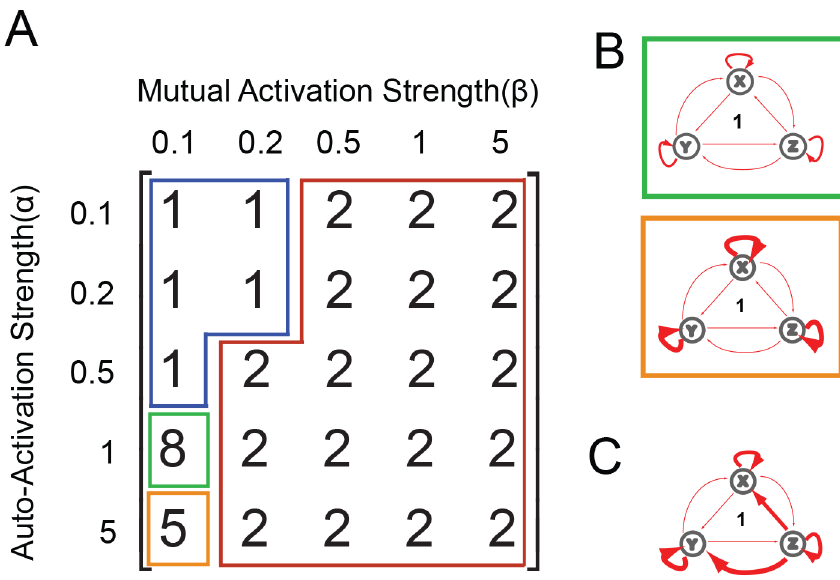
Figure 6. Stable Steady State Analysis of Network 1. (A) A matrix defined by examining the number of SSS present at points where all auto- regulatory strengths (row) are equal and mutual-regulatory strengths (column) are also equal. This provides an overview of network stability at various points in the parameter regulation space; the green and brown regions are visualized as FCT diagrams independently in B. (B) The green- boxed diagram corresponds to the green-boxed parameter combination regime from (A), where genes have regulatory strengths a =1 and b =0.1. The orange-boxed diagram corresponds to the orange-boxed parameter combination regime from (A), where nodes have regulatory strengths a =5 and b =0.1. This parameter combination regime allows the system stability in 5 of the 8 Stable Steady States, losing only the two-ON states. (C) As in Figure 4C, there exist parameter combinations not captured by the matrix representation, where increased strength of any one of the five regulations (represented by thick arrows) will enable 5 SSS.